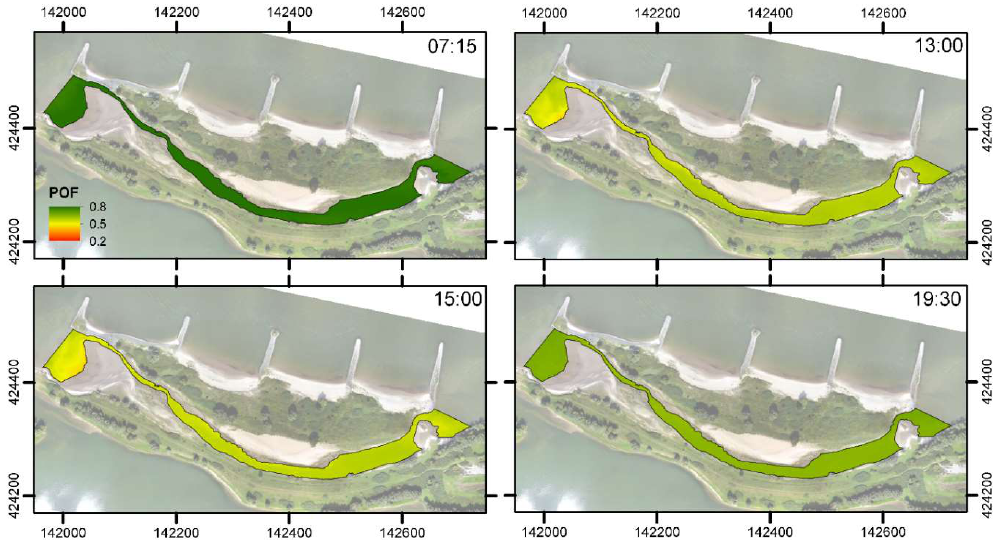
Figure 7. The potentially occurring fraction (POF) of alien species in the northern side channel along the river Waal near Gameren derived from remotely sensed water temperatures during a hot summer day.